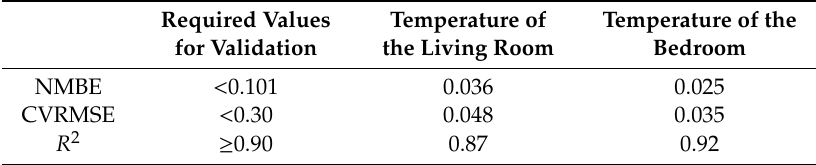
Table 3. Statistical values of calibration indices.